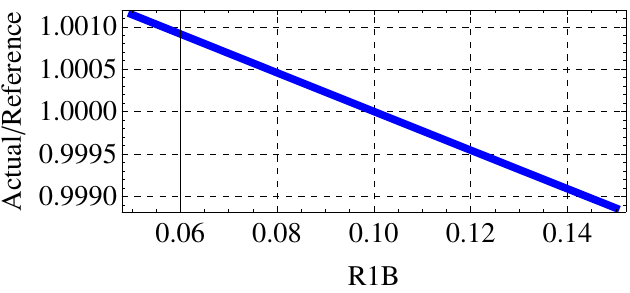
Figure 24. Ratio of the actual to ideal reference current with respect to line resistance.